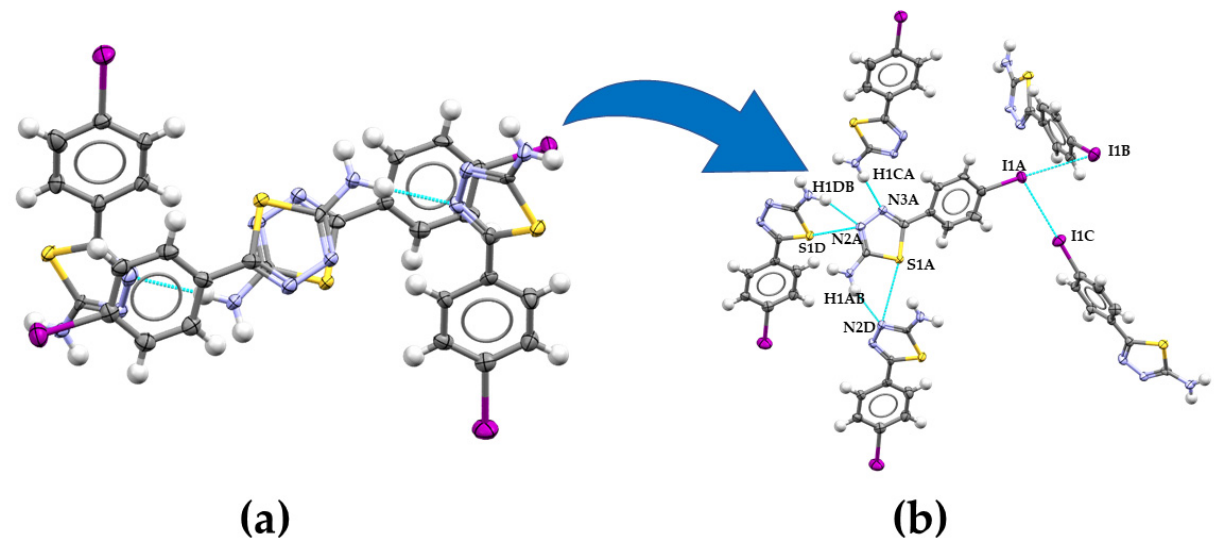
Figure 6. (a ) Asymmetric unit and ( b ) main intermolecular interactions in one of the four unique molecules in the crystal structure of T1-S-I, Form I.